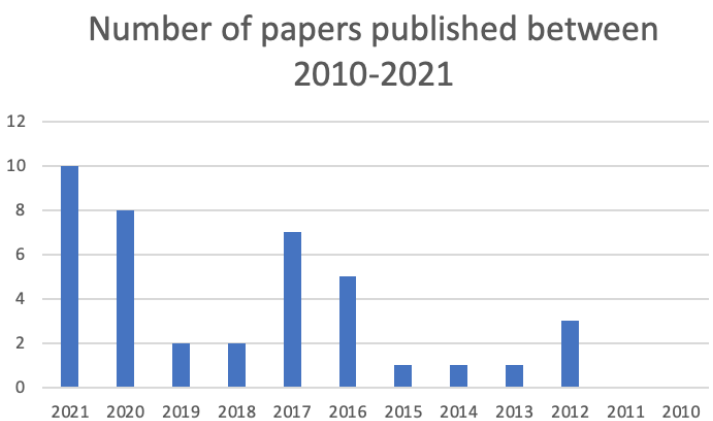
Figure 2. Number of NLP papers applied to occupational exposure research published each year from 2010 to